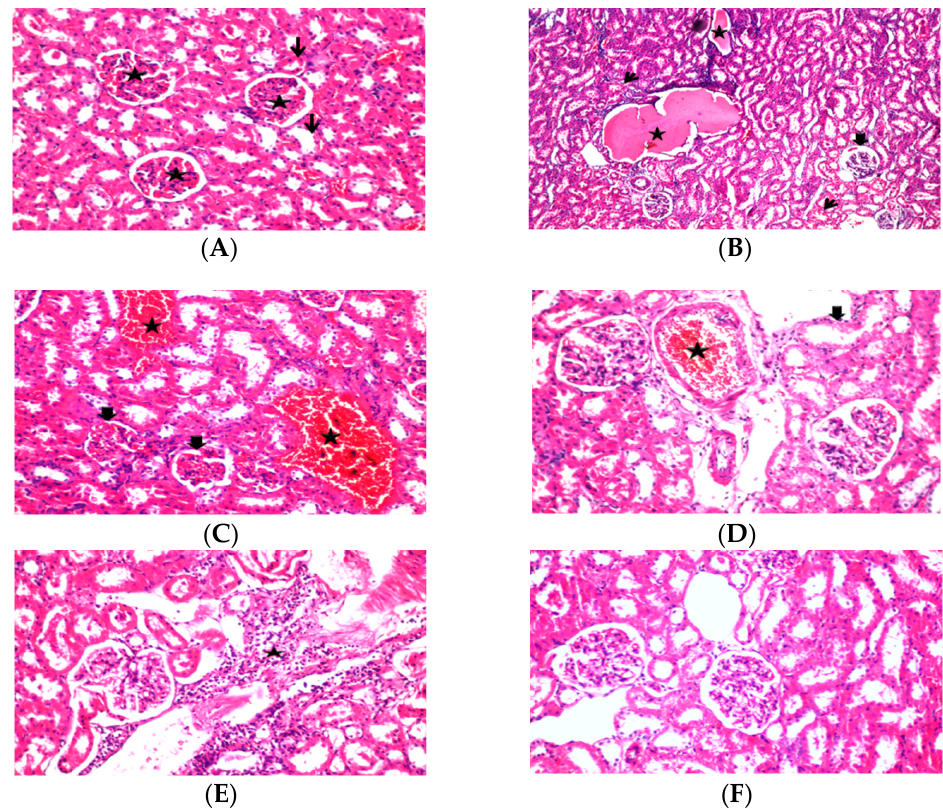
Figure 4. Hematoxylin-eosin (H&E x300) stained sections of rat kidneys; ( A ) normolipidemic controls, NC; ( B ) hyperlipidemic controls, PC; ( C ) rats treated with cow fermented milk using traditional starter culture; ( D ) rats treated with camel fermented milk using traditional starter culture; ( E ) rats treated with fermented camel and cow’s milk using traditional starter culture; and ( F ) kidney sections of rats treated with fermented camel and cow’s milk using probiotic culture.